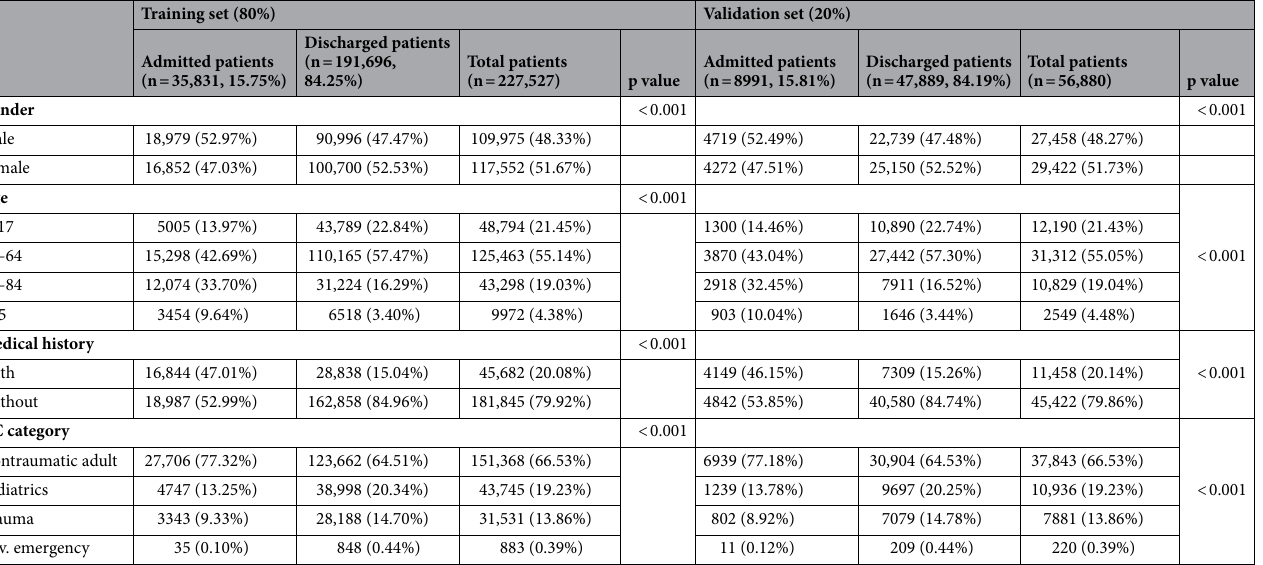
Table 1. Descriptive analysis of all patients included in the training and validation sets. CC chief complaint, Env. emergency environmental